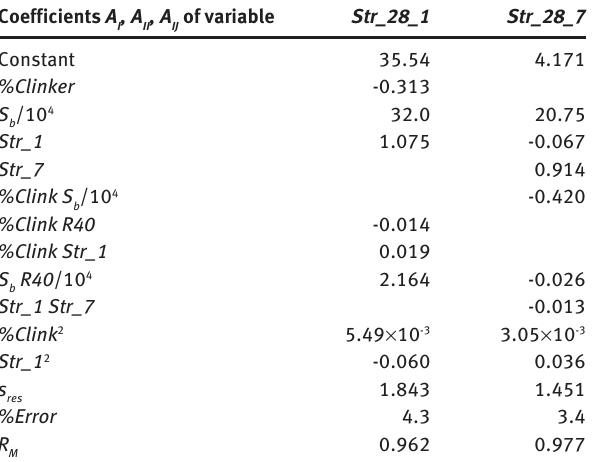
Table 2 The parameter values of the models.